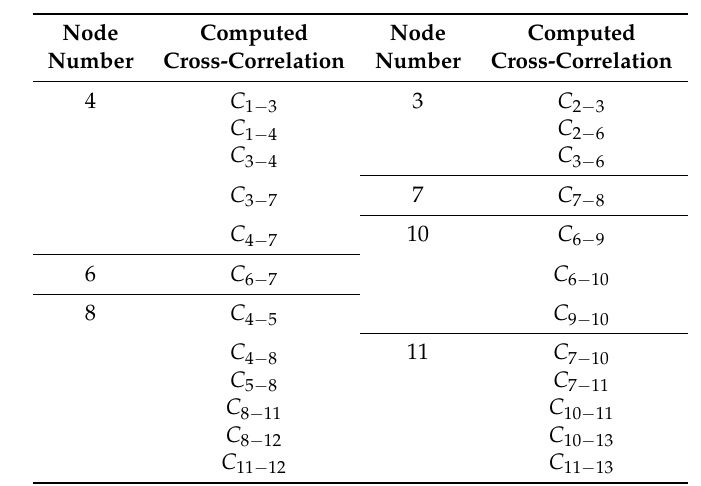
Table 4. Number of cross-correlations for each selected node (limited bandwidth up to 4 neighbors).